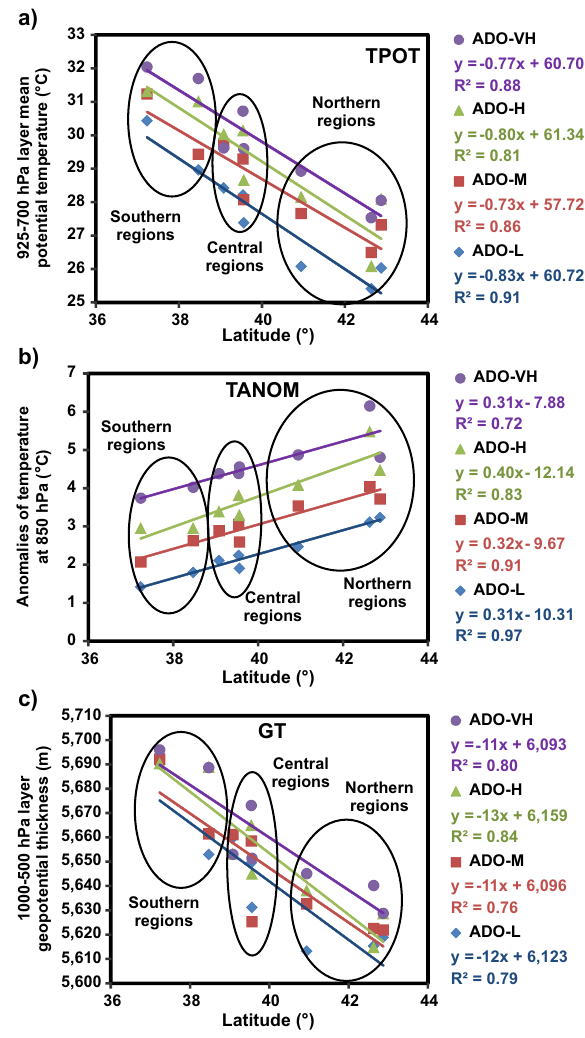
Fig. 4 Variation of the thermodynamic parameters with the latitude during ADO. Linear regressions between the latitudes of the regional background air quality monitoring stations and the mean values of TPOT ( a ), TANOM ( b ) and GT ( c ) registered over each region of study during ADO of different intensity in the period 2001 – 2020. ADO-L low event, ADO-M moderate event, ADO-H high event, ADO-VH very high event.